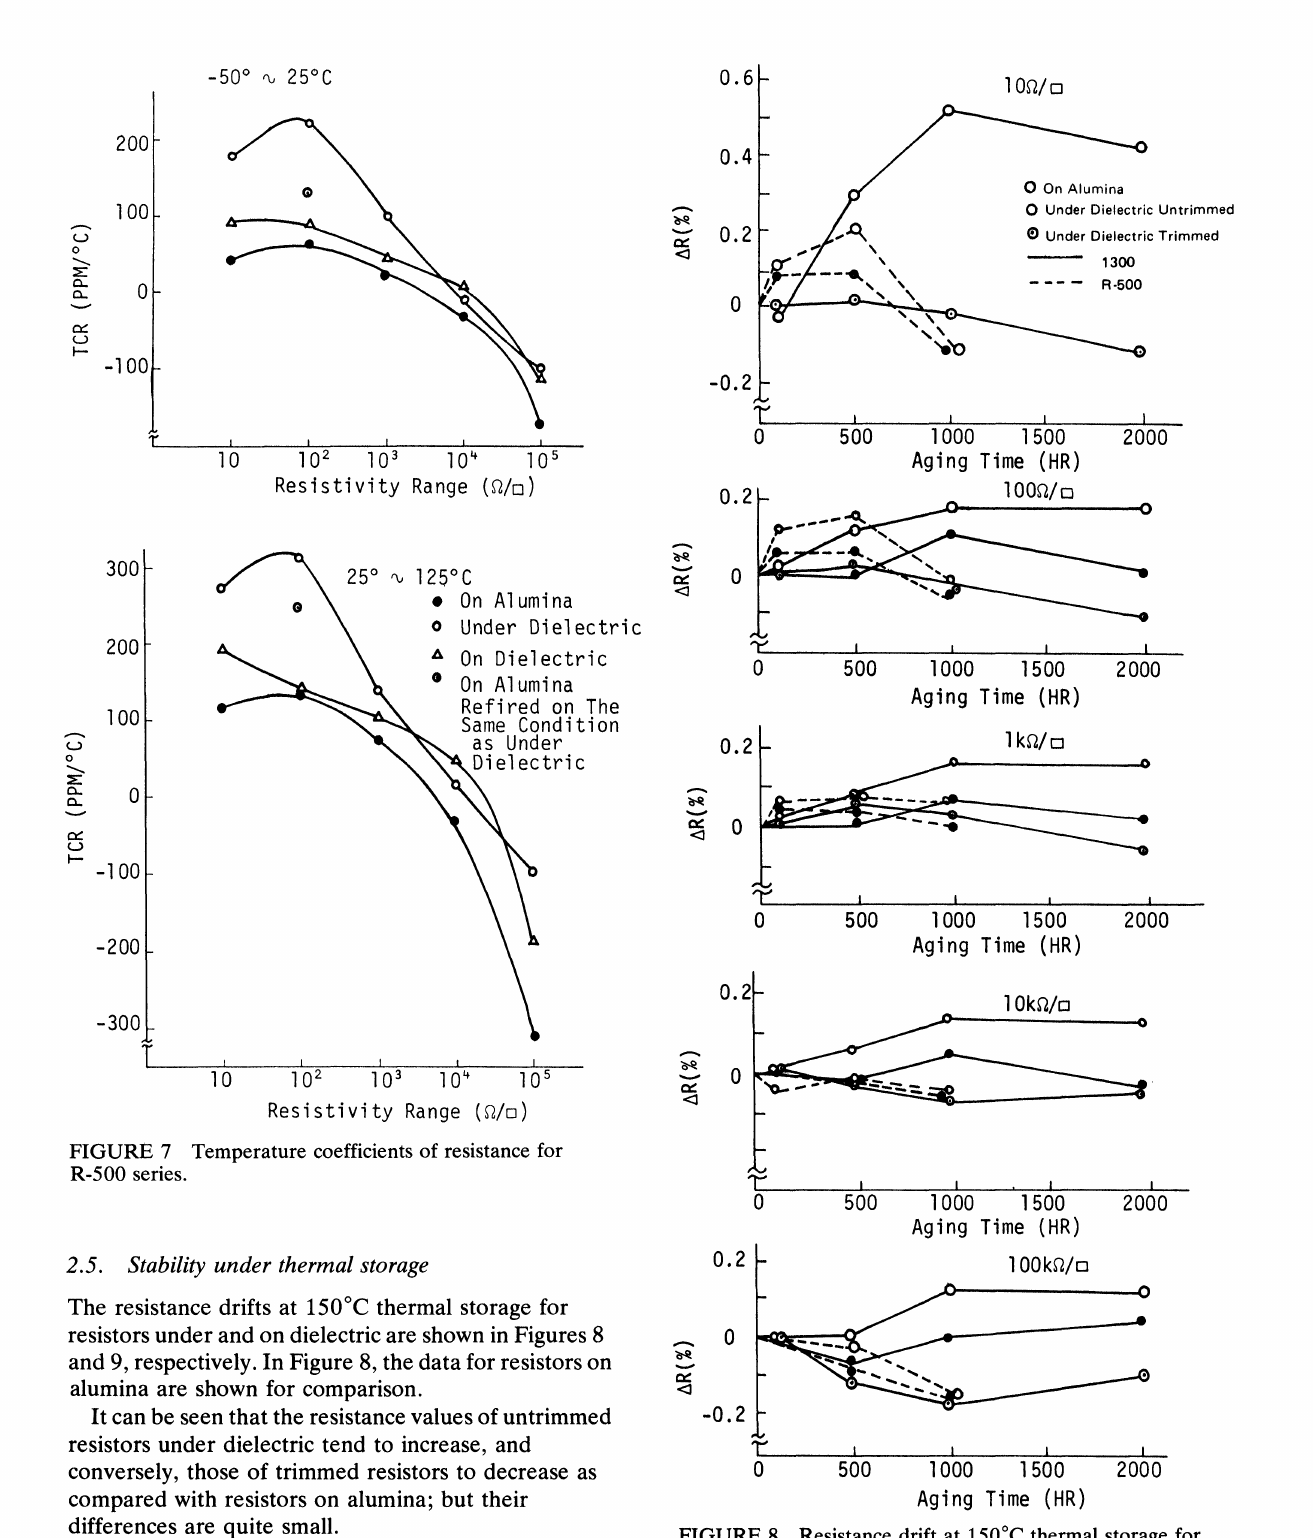
FIGURE 8 Resistance drift at 150C thermal storage for resistors under dielectric and on